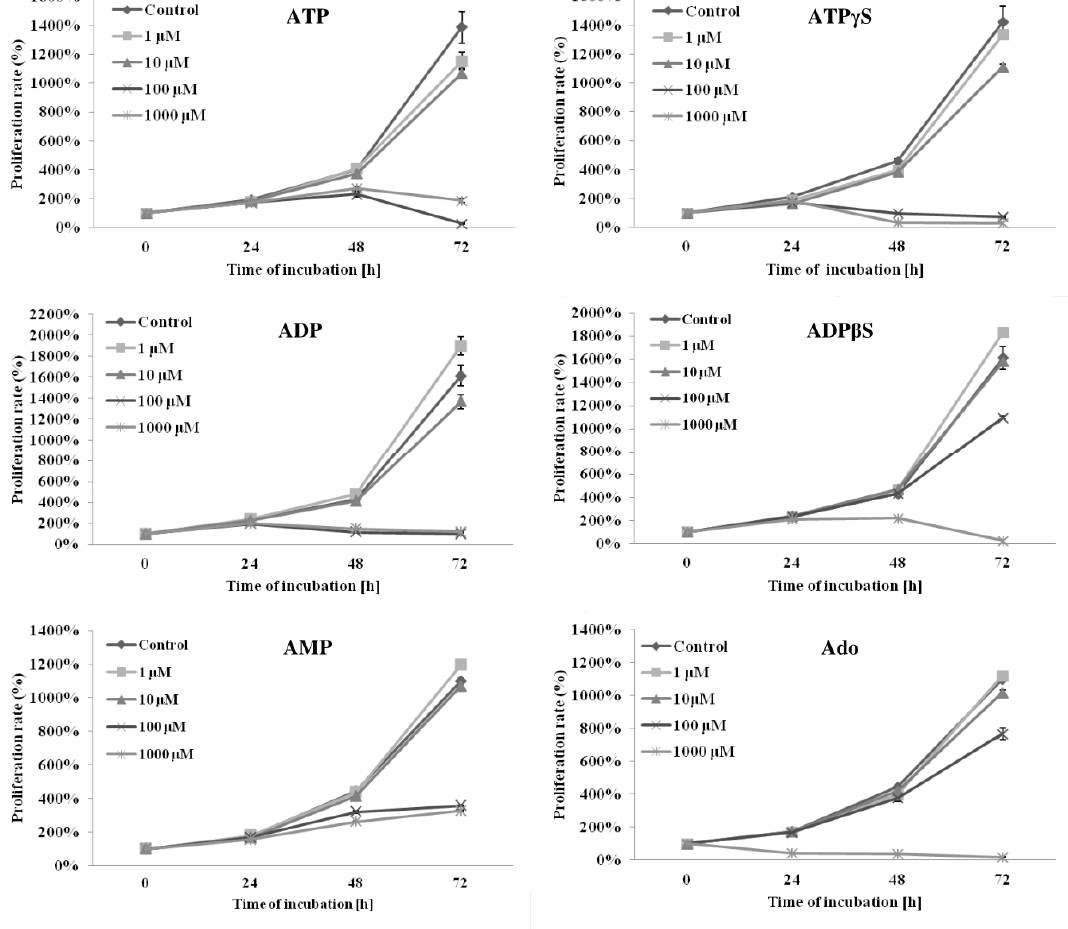
Figure 2. The effects of high (100–1000 µM), intermediate (10 µM) and low (1 µM) concentrations of adenine nucleotides or adenosine (Ado) on the proliferation of THP-1 cells. The proliferation rate (%) was evaluated after 24, 48 and 72 h of incubation by counting the number of cells using a flow cytometer. Data are presented as the mean ± SD of three different experiments. p < 0.05 compared with the unstimulated control cell culture.